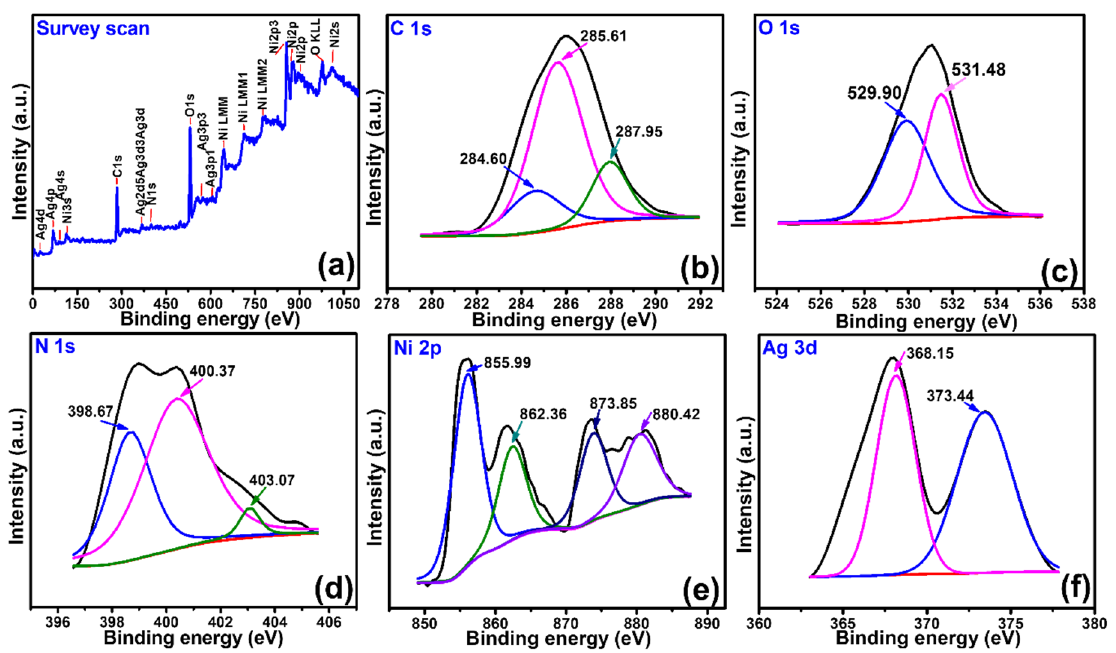
Figure 4. ( a ) XPS survey scan of the Ag/GN@PPy − Ni(OH) 2 nanocomposite. The deconvoluted spectra of C1s ( b ), O1s ( c ), N1s ( d ), Ni2p ( e ), and Ag3d ( f ).